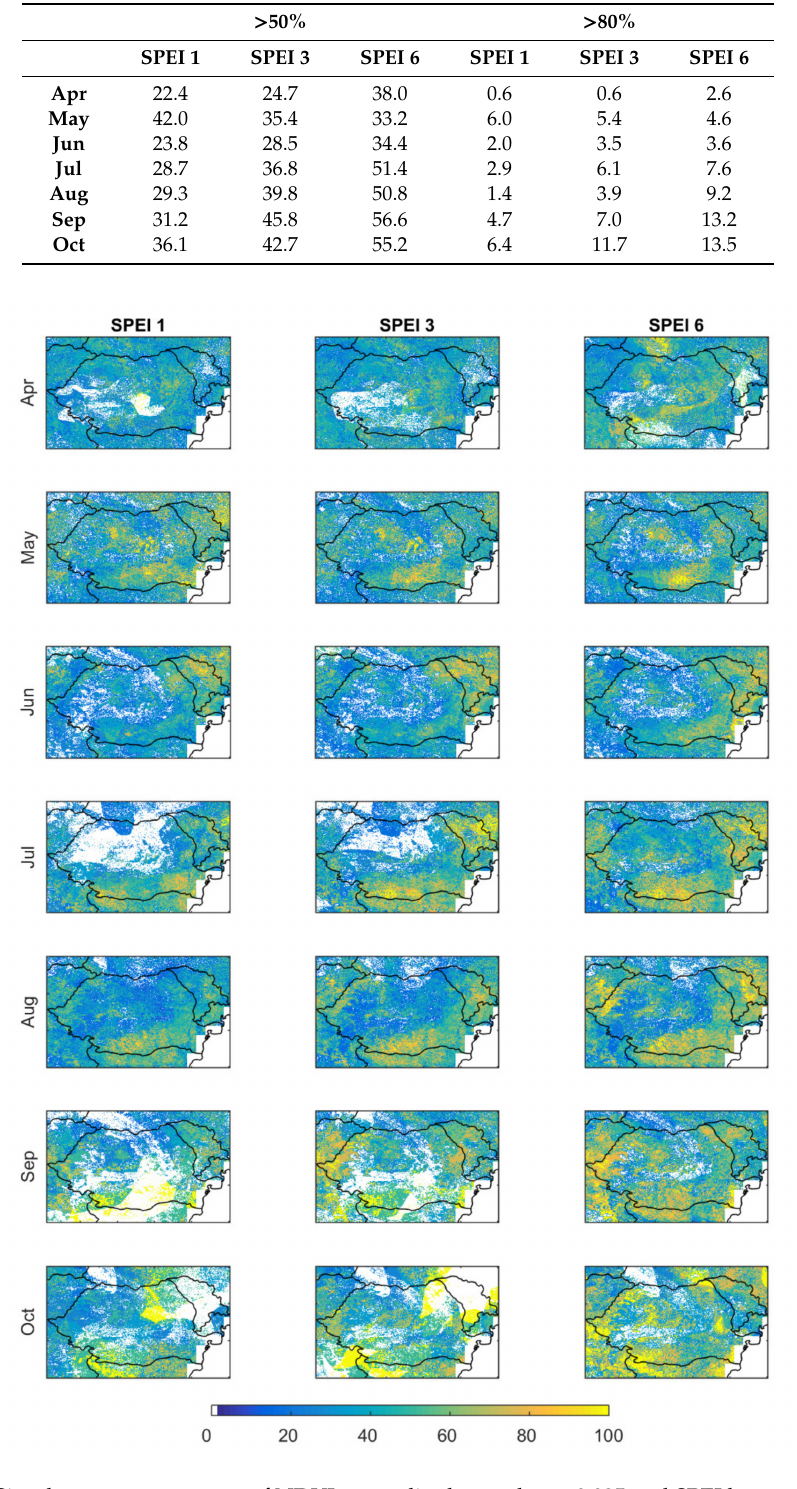
Figure 3. Simultaneous occurrence of NDVI anomalies lower than − 0.025 and SPEI lower than − 0.84, shown as a percentage of the number of months showing SPEI lower than − 0.84, for the months of April to October and the time scales of 1, 3 and 6